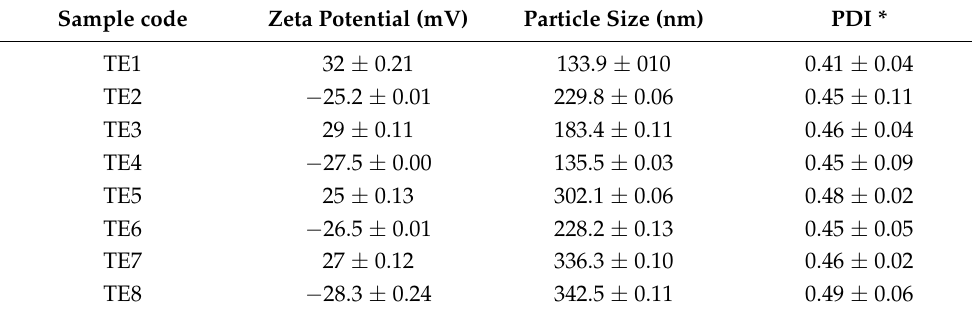
Table 1. Particle size, zeta potential, and PDI of nanovesicles (Mean ± SD, n = 5). Sample